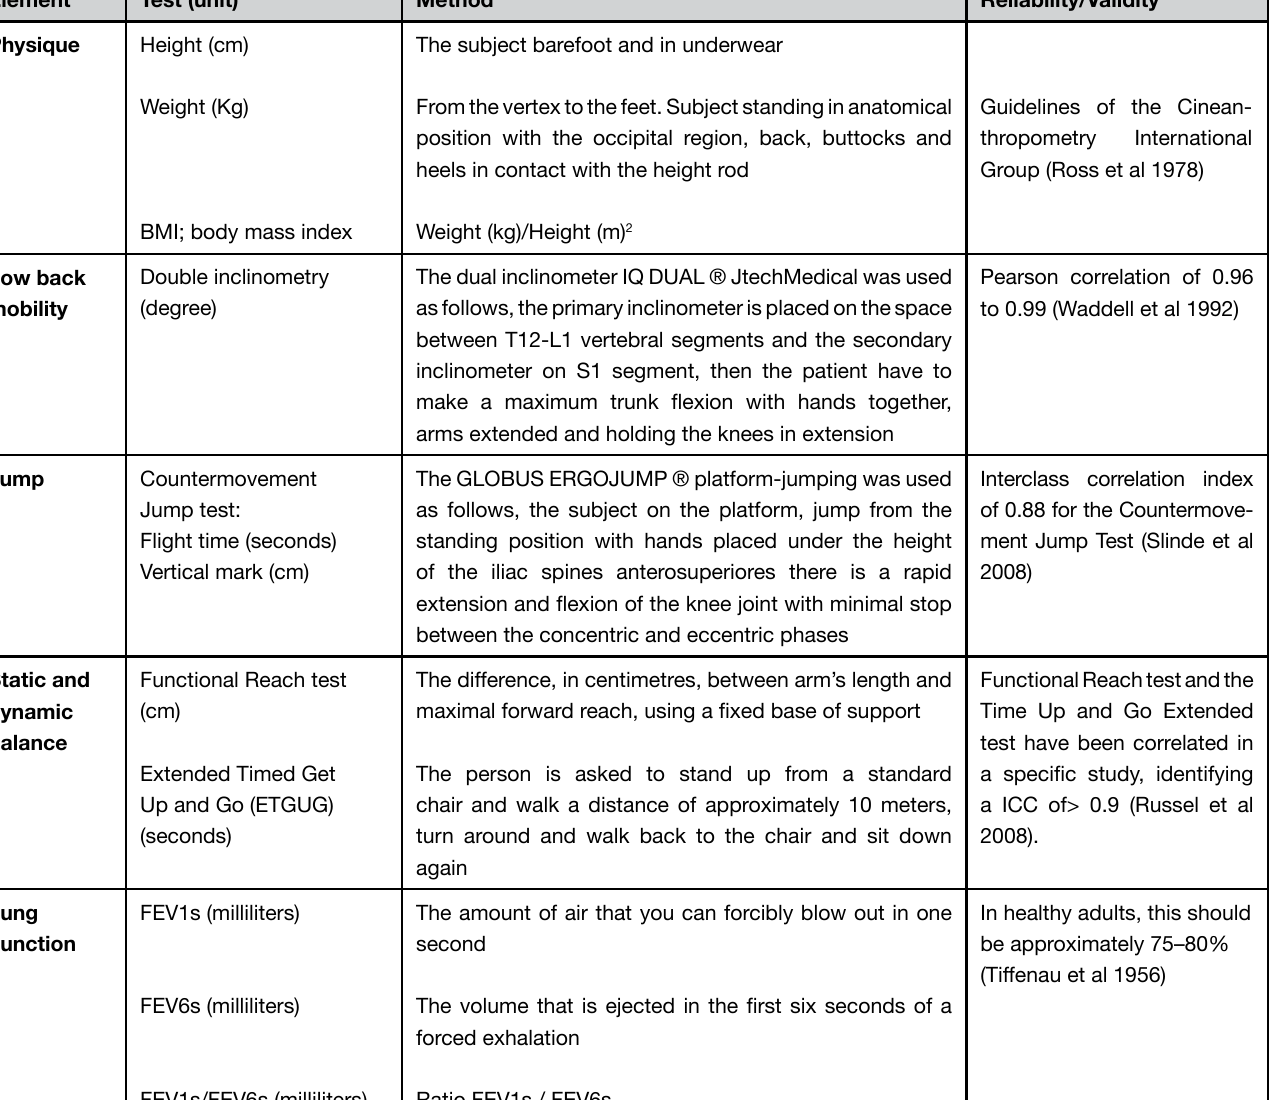
Table 1: Assessment of physical fitness.